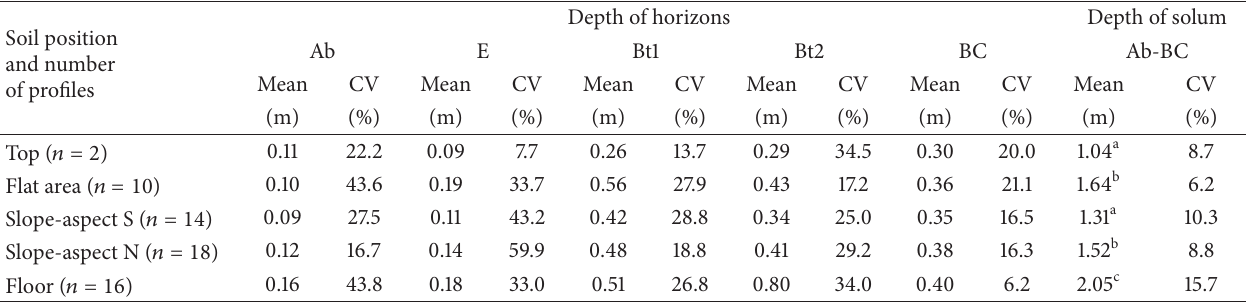
Table 5: Depth of soil horizons in noneroded (apart from Ap horizon) and buried soils, depth of soil solum, and results of ANOVA; means were separated by Tukey’s HSD